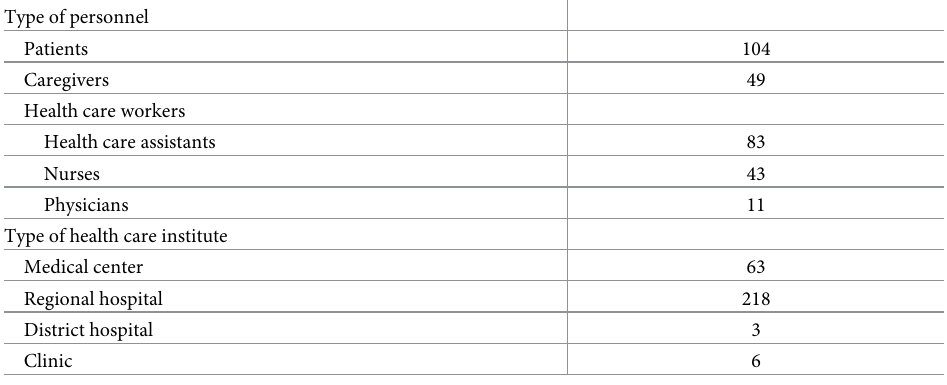
Table 3. Number of COVID-19 nosocomial infections (n =